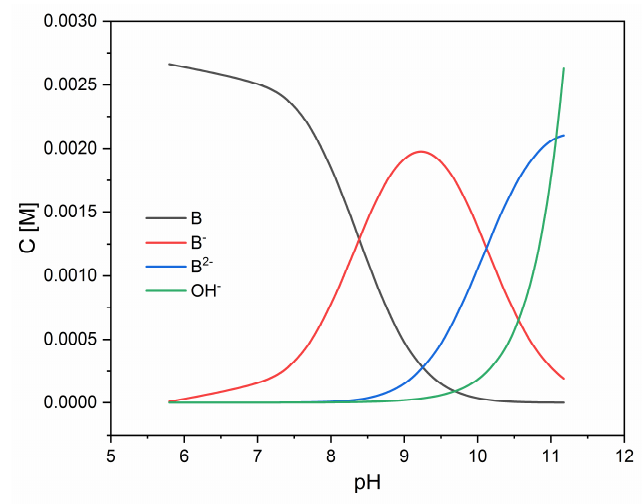
Figure 1. Species distribution diagram for the potentiometric titration.